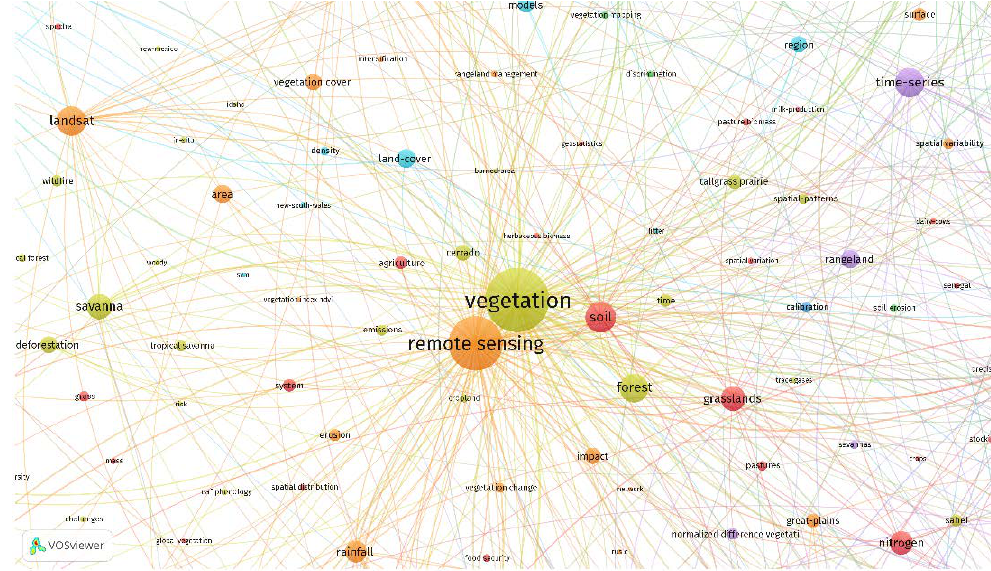
Figure A2. Links of the “Vegetation” and “Remote Sensing” keyword zoomed-in Figure 6 from 1980 to 2020.